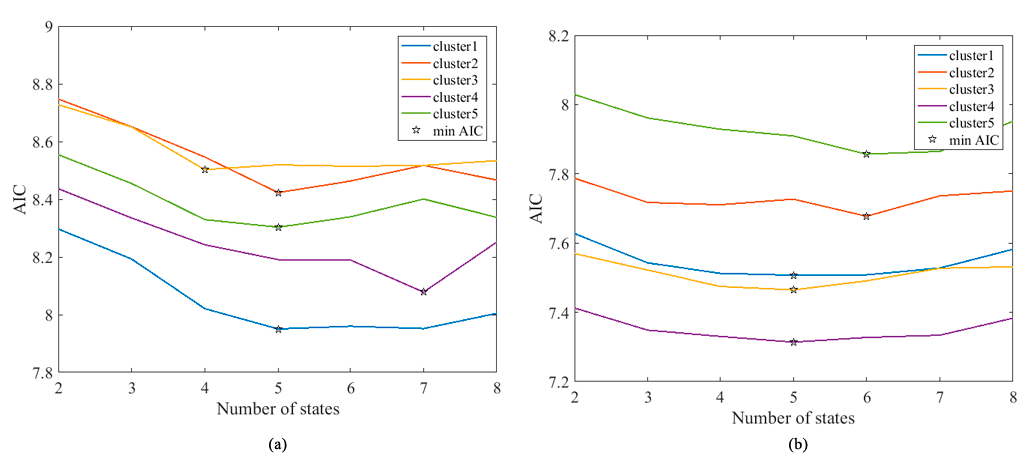
Figure 12. Akaike Information Criterion (AIC) values for different model structures, where (a) is for cultivated land and (b) is for built-up land.